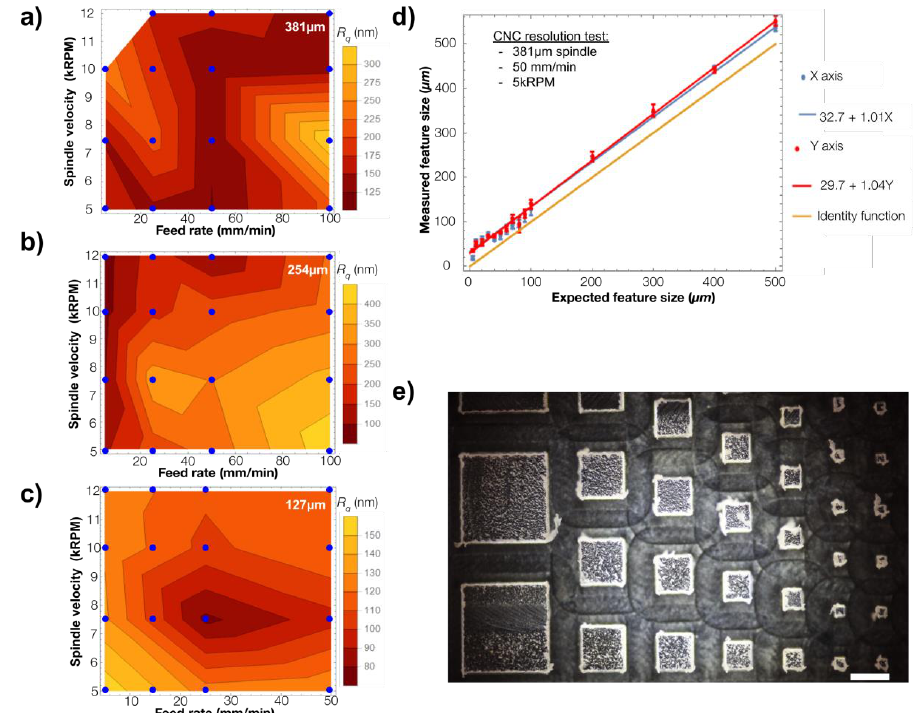
Figure 5. ( a – c ) CNC micromilling roughness tests using 3 different end-mill diameters, 381 µm, 254 µm, 127 µm, respectively; the R q roughness is plotted as a function of both the feed rate and the spindle velocity, the blue points represent our experimental data. ( d ) Comparison between the designed dimension of the features in the resolution test sample and its measurement, the blue line shows the linear fit made to X-Axis data and in red the linear fit of the Y-Axis data, for comparison in yellow the identity function is plotted, each measurement was repeated 6 times, scale bars represent the standard deviation. ( e ) Sample of the out-of-plane square pillars used for the resolutions test. Scale bar is 500 µm.